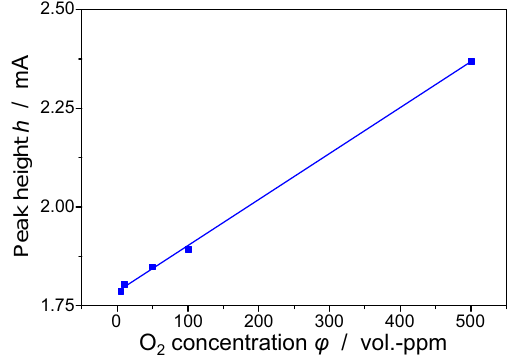
Figure 10. Heights of the O 2 peaks from Fig. 9 depend- ing on the O 2 concentration; the peak heights were calculated as the difference between the current at the peak minimum and the current at − 0 . 55V. Linear fit function: h /mA = 1 . 16 × 10 − 3 ϕ vol.ppm − 1 + 1.786.